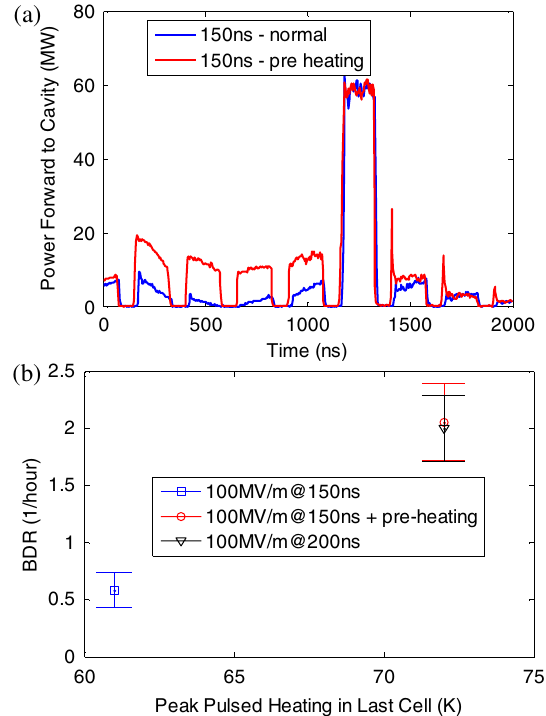
FIG. 9. (a) Input power waveforms and (b) test results for high- power runs of the HOM-damped multicell X -band TW cavity high-power test with and without prepulse heating.